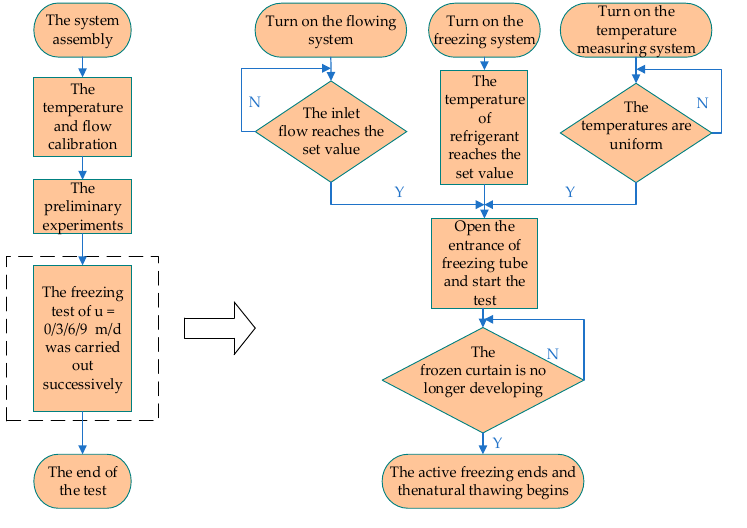
Figure 6. Test scheme and process.